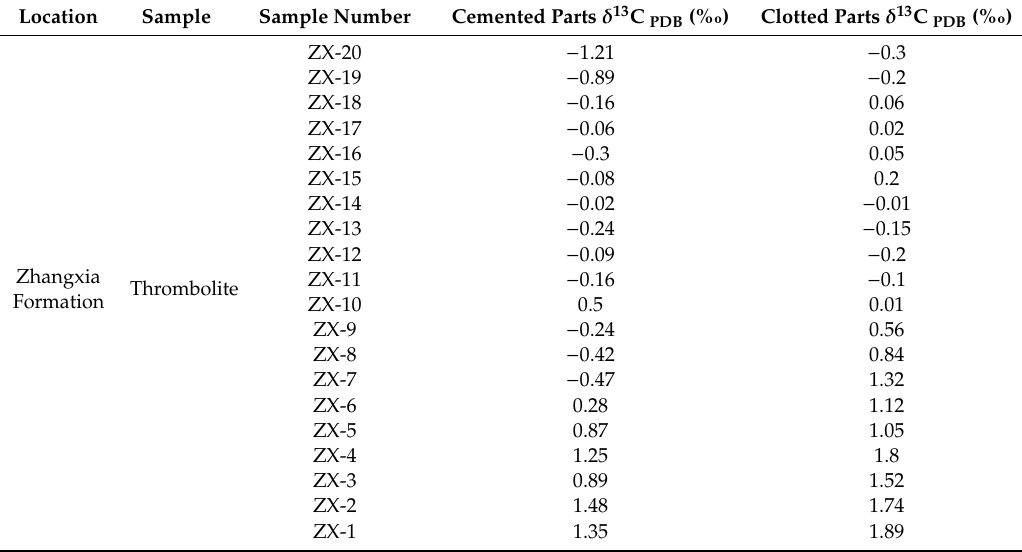
Table 4. Stable carbon isotope δ 13 C PDB (% (cid:24) ) values of cemented and clotted parts in thrombolite.